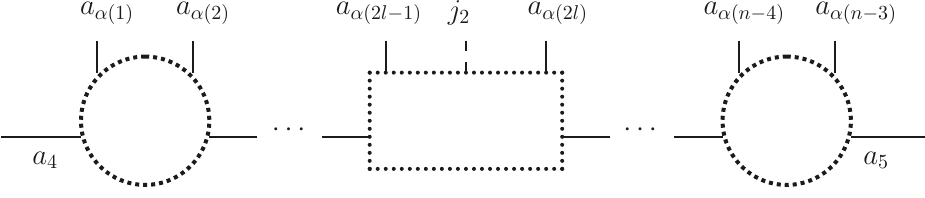
Figure 14 . The second kind of flavor factor in eq. (A.2), where the structure inside the dotted box is given by figure